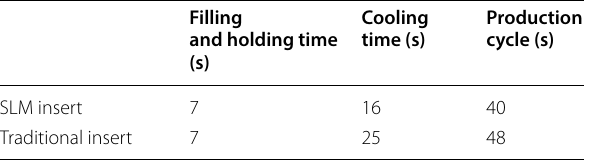
Table 3 Production efficiency of the two kinds of